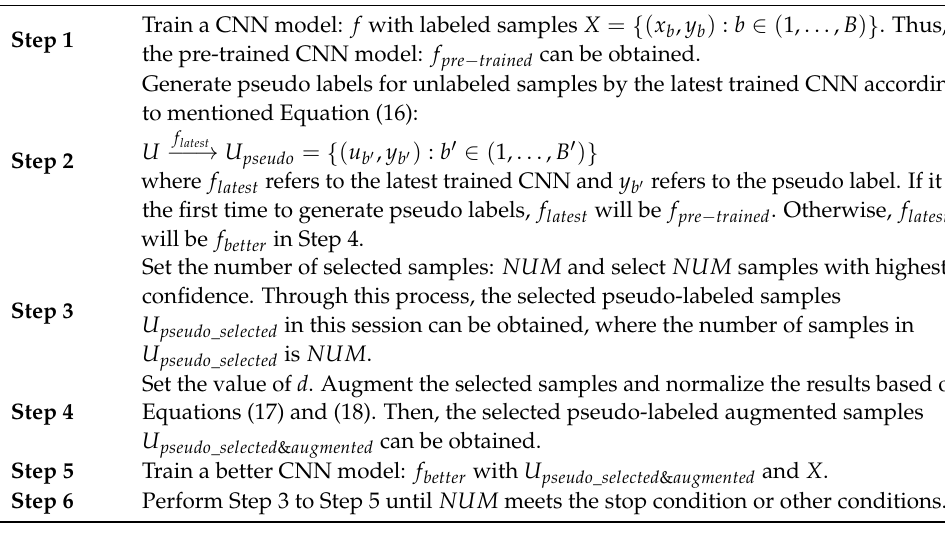
Algorithm 3. The algorithm of accomplishing the semi-supervised classification task based on CNN and selecting samples by controlling the number and self-paced data